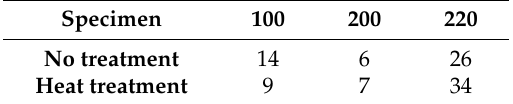
Table 3. Sizes of the strongest diffraction peak of alloy 800H in two states